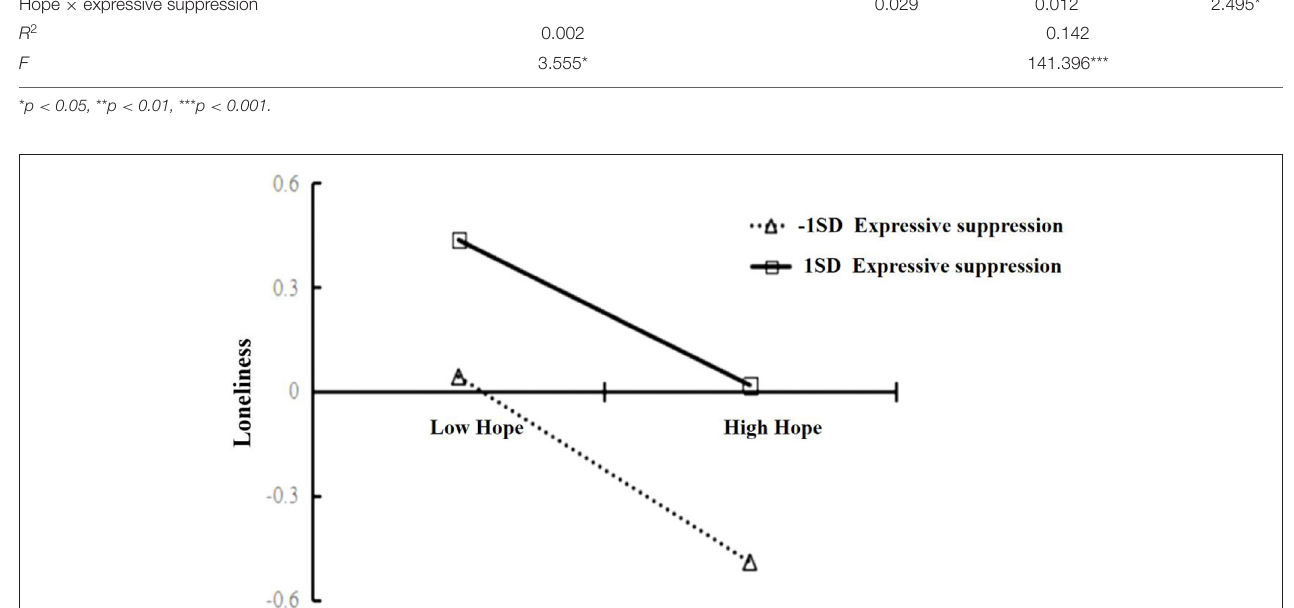
FIGURE 2 | Predictions for the Interaction between loneliness and hope by expressive suppression values.